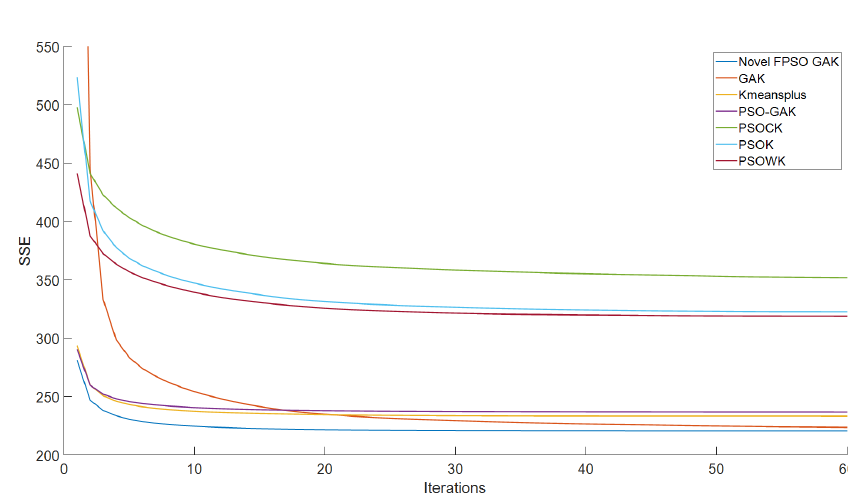
Figure 10. The SSE convergence curve of taxi GPS dataset from Beijing (China).